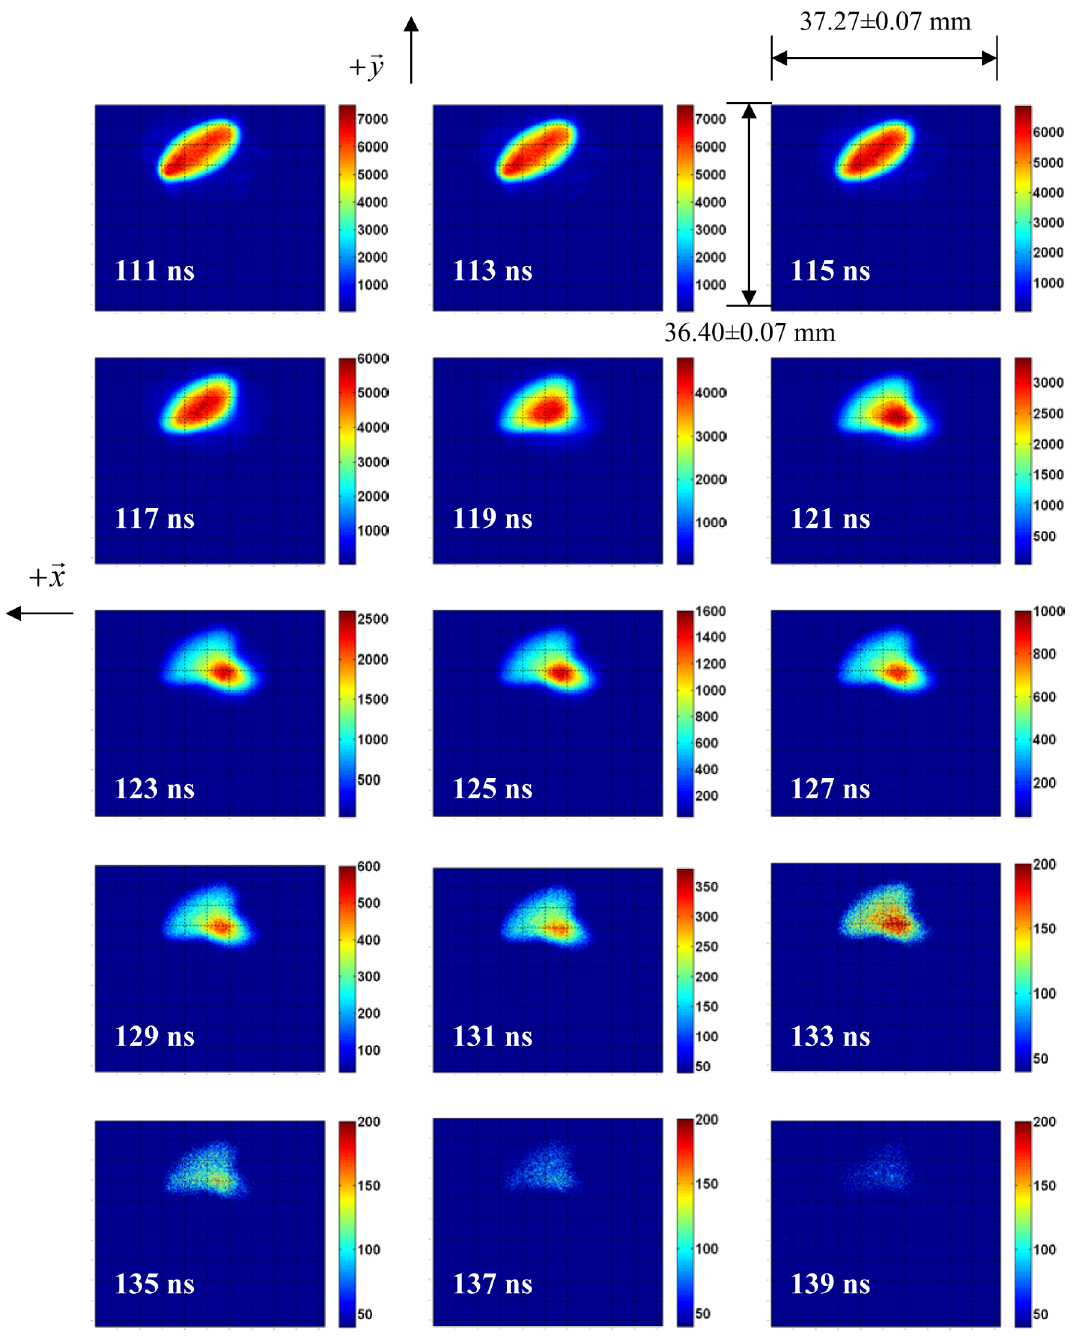
FIG. 10. 3 ns gated camera images of the 21 mA beam tail , measured at RC15 as a function of time along the beam